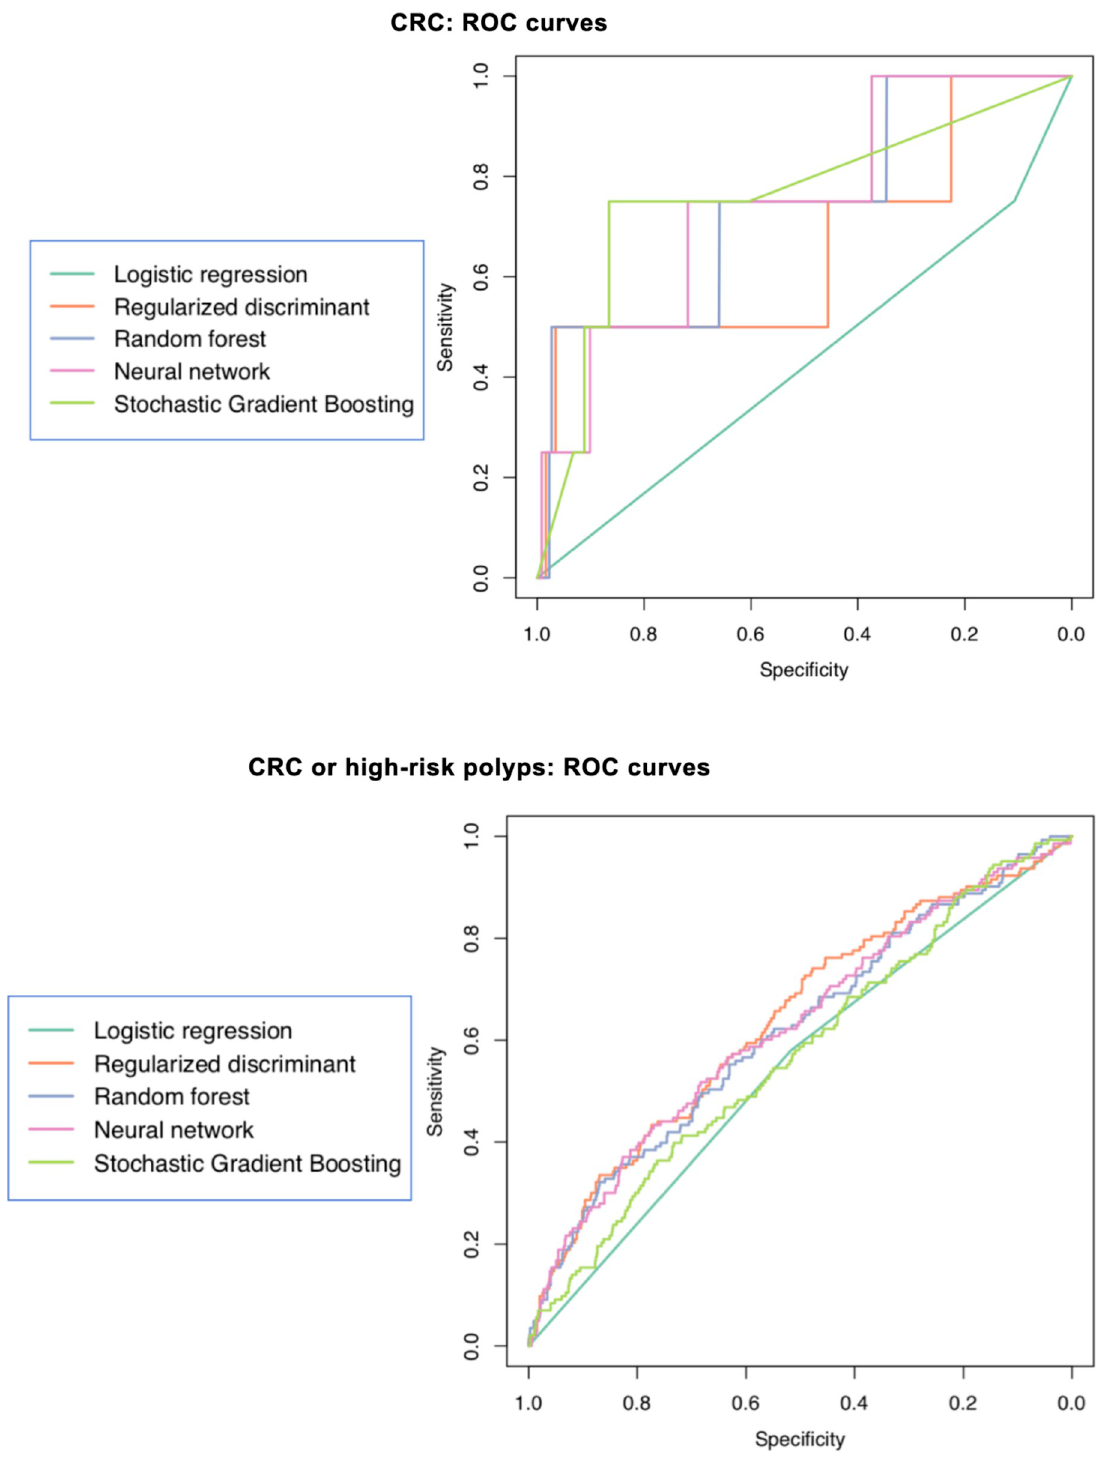
Fig 2. Receiver Operator Curves (ROC) of the reference and machine learning models in the test set for colorectal cancer (CRC) and CRC or high-risk polyps (bottom).